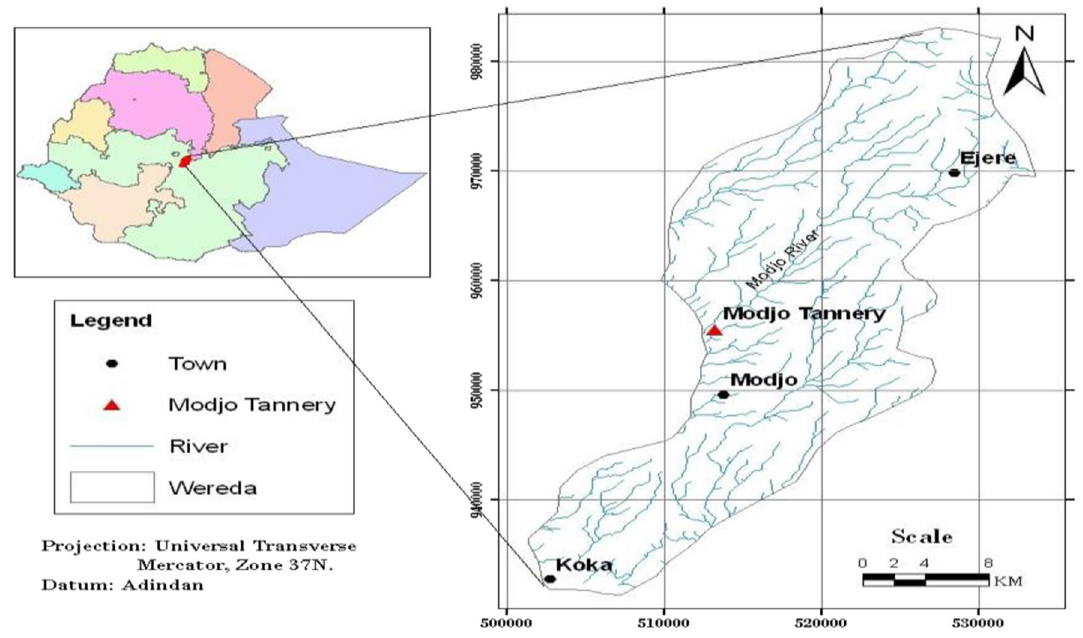
Fig. 1 Location of the study site within the Modjo River